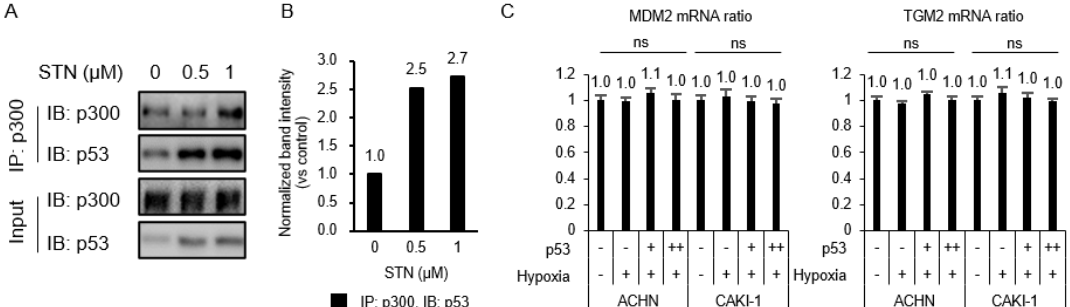
Figure 3. p53–HIF-1 α complex is inhibited by TGase 2 inhibition in hypoxia. ( A ) ACHN cells were treated with STN for 2 h and incubated for 4 h in hypoxia (1% O 2 ). The proteins were immunoprecipitated from cell extracts using an anti-p300 antibody and subjected to immunoblotting. ( B ) The image J analysis of Western blotting of Figure 3A. ( C ) Cells were transfected with 3xFLAG p53 (p53 overexpression vector; 0, 2, 4 μg) for 8 h and incubated for 4 h in hypoxia. The total RNAs were isolated from cells and RT-PCRs against mouse double minute 2 homolog (MDM2), TGM2, and GAPDH were performed as described in the method. GAPDH was used as an internal control for the RT-PCR system. Error bar represents SD. GraphPad Prism software used to perform one-way ANOVA, ns = not significant. Data are representative of three independent experiments.